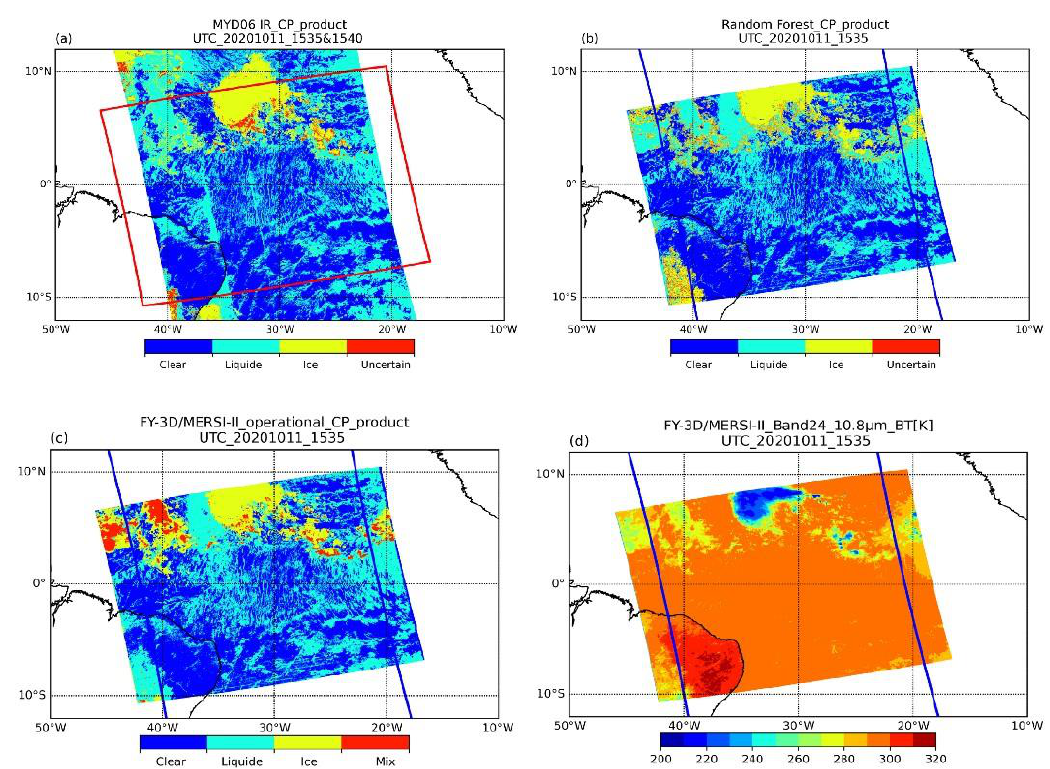
Figure 7. Comparisons of CP at low latitudes on 11 October 2020 for ( a ) the MODIS CP product at 15:35 and 15:40 UTC, ( b ) the RF CP product at 15:35, ( c ) the operational FY-3D/MERSI-II CP product at 15:35 UTC, and ( d ) the FY-3D/MERSI-II band 24 BT image at 15:35 UTC. The red box is the outline of the 15:35 UTC FY-3D image, and the blue box is the contour of the 15:35 and 15:40 UTC Aqua images.